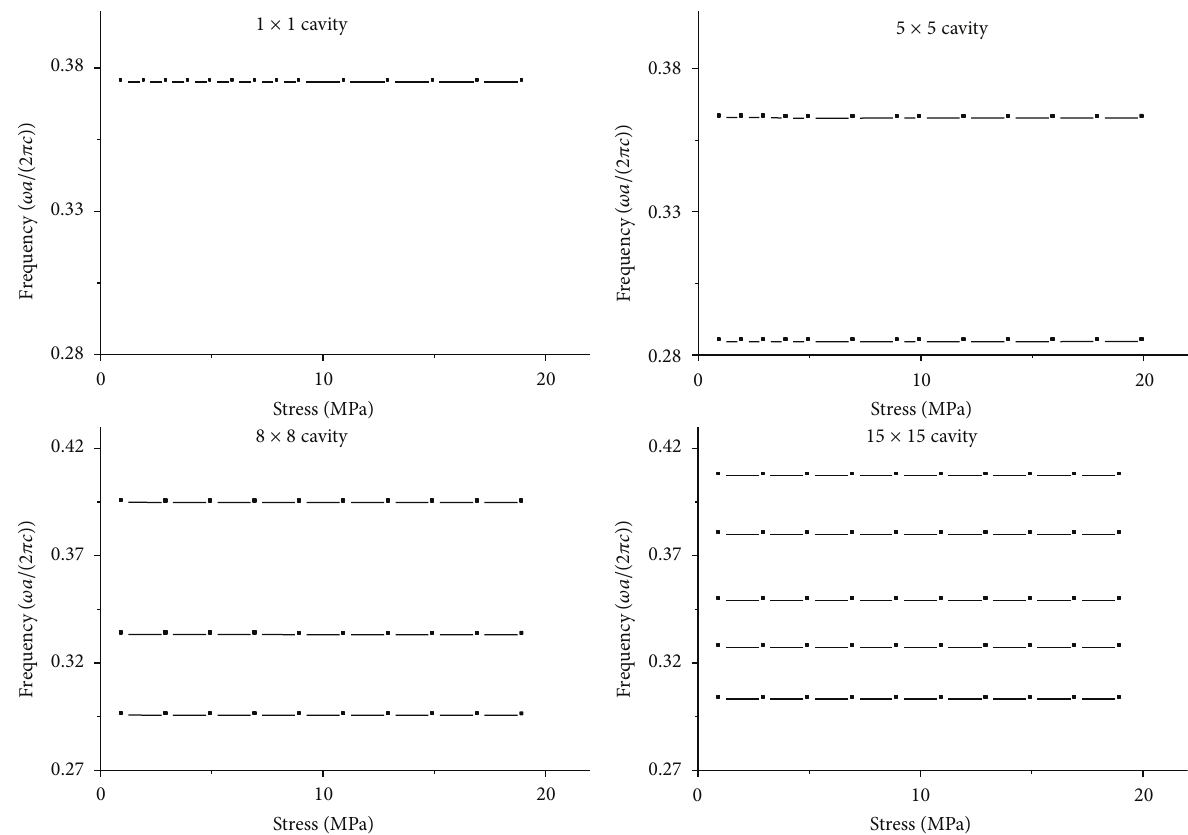
Figure 3: The resonant frequency for 𝑛 × 𝑛 cavity change with stress on 𝑥 direction. 1 × 1 , 5 × 5 , 8 × 8 , 15 × 15 represent cavities with 𝑛 rows and 𝑛 columns